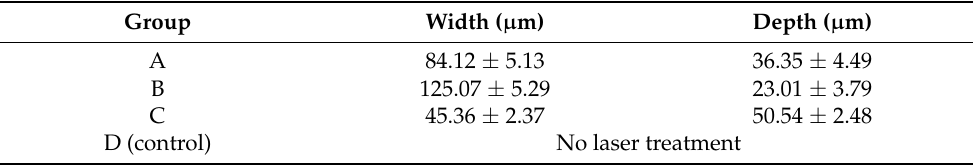
Figure 1. The FEG-SEM micrographs taken after the surface treatment of all samples (100 × magnification). Table 1. A schematic table of the results obtained in terms of width and depth grooves by an innovative laser technique in µ m (N =